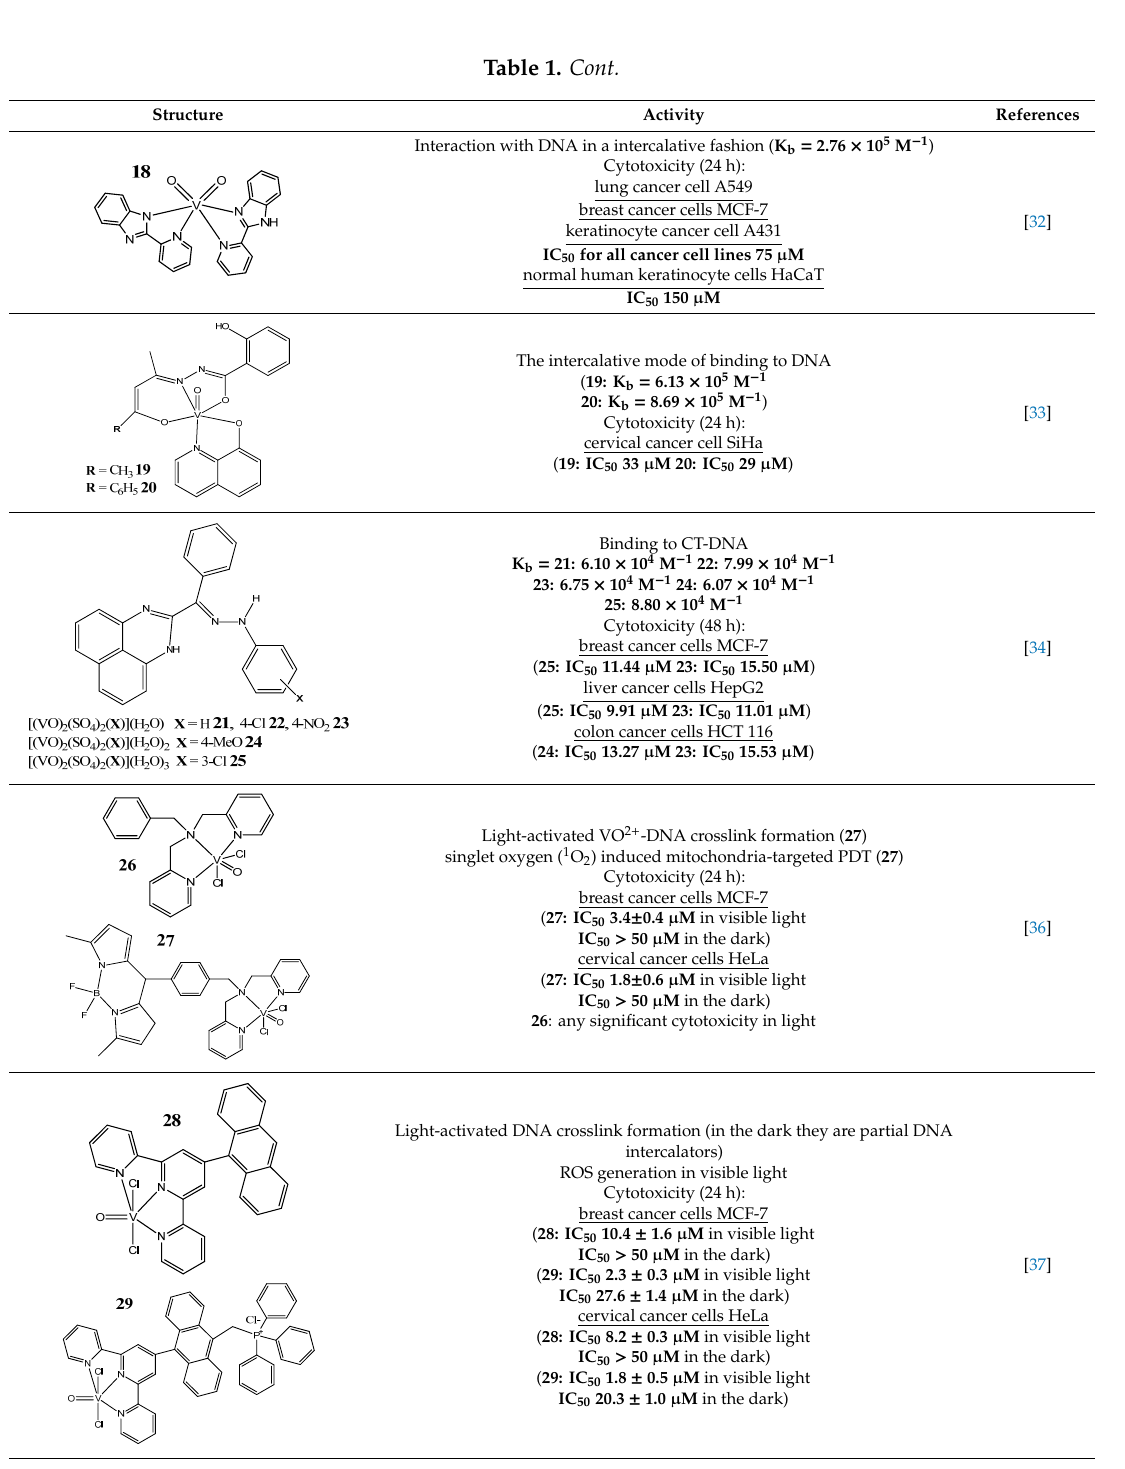
Photo-induced cleavage of pUC19 supercoiled plasmid DNA Interaction with CT-DNA through minor groove binding mode